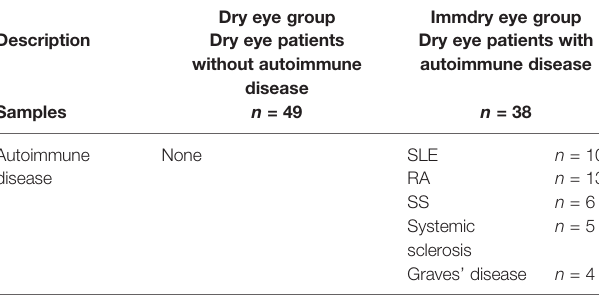
TABLE 1 | Characteristics of the two